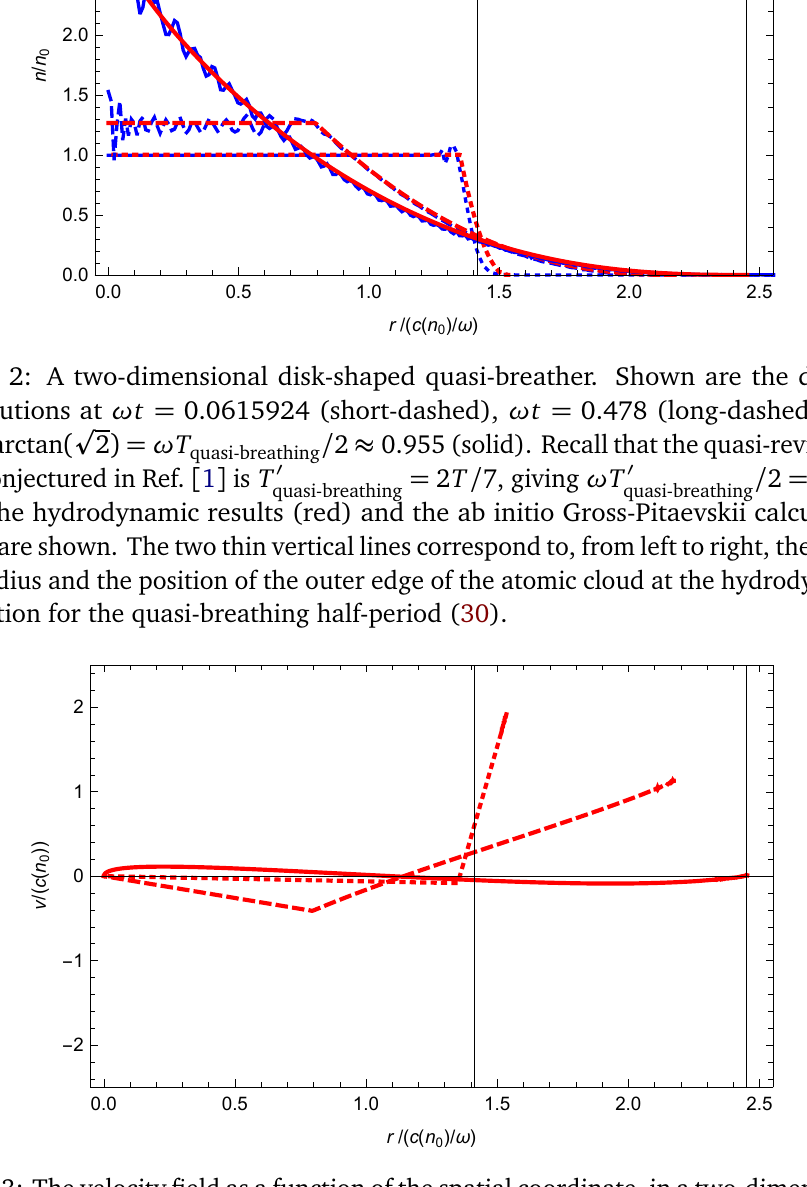
Figure 3: The velocity field as a function of the spatial coordinate, in a two-dimensional disk-shaped quasi-breather. The observation times, the line dashing and color conven- tion, and the meaning of the thin vertical lines are the same as in Fig.